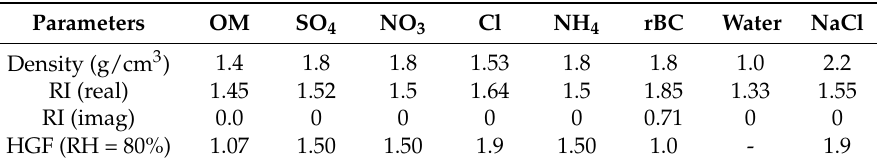
Table 1. Assumed size-independent density, real and imaginary parts of complex refractive index (RI) at 0.55 µ m wavelength, and hygroscopic growth factor (HGF) values used in this study. Values are taken from [39–41]. Also, this table includes values of these parameters for sea salt (or sodium chloride; NaCl) from Xie et al.